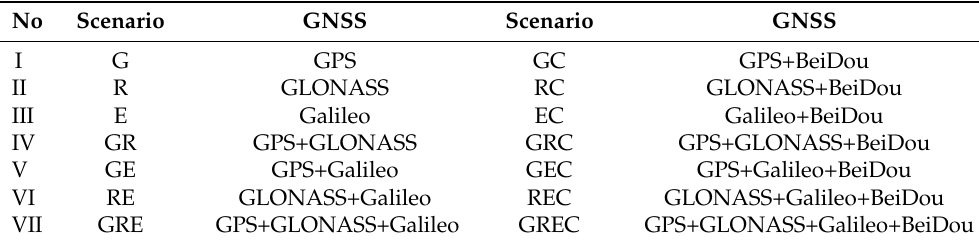
Table 2. Processing